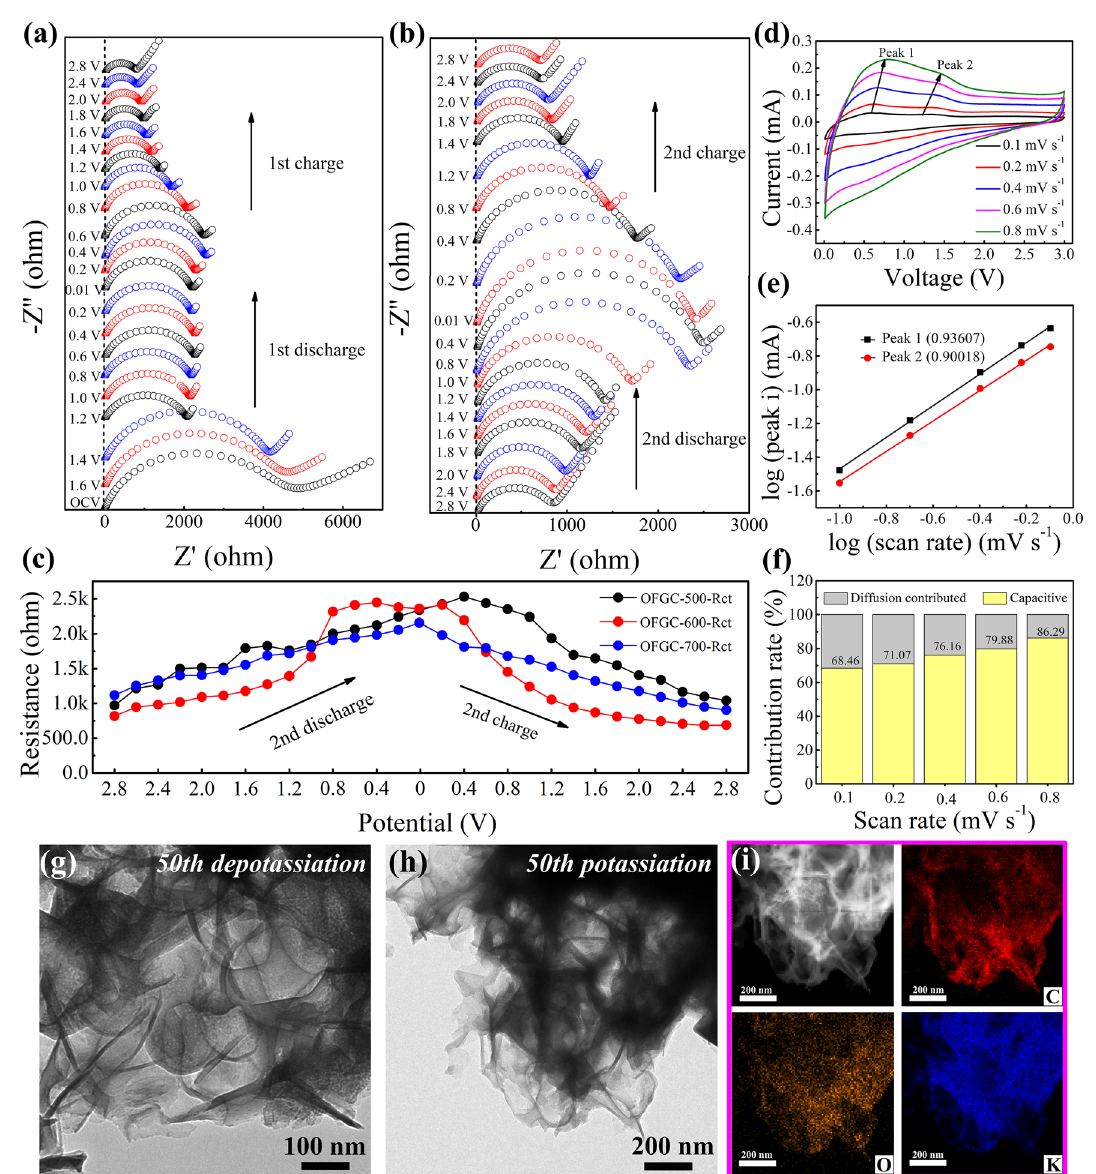
Fig. 5 a - b Nyquist plots of OFGC-600 during charge and discharge for the first two cycles and c the charge transfer impedances ( R ct ) of OFGC- 500/600/700 at the second cycle. d CV curves and e the b values plotted for the potential anodic peak. f Capacitive contribution under scan rates of 0.1, 0.2, 0.4, 0.6, and 0.8 mV s −1 . g – h TEM images after 50th depotassiation and 50th potassiation. i EDX elemental mapping of C, O, and